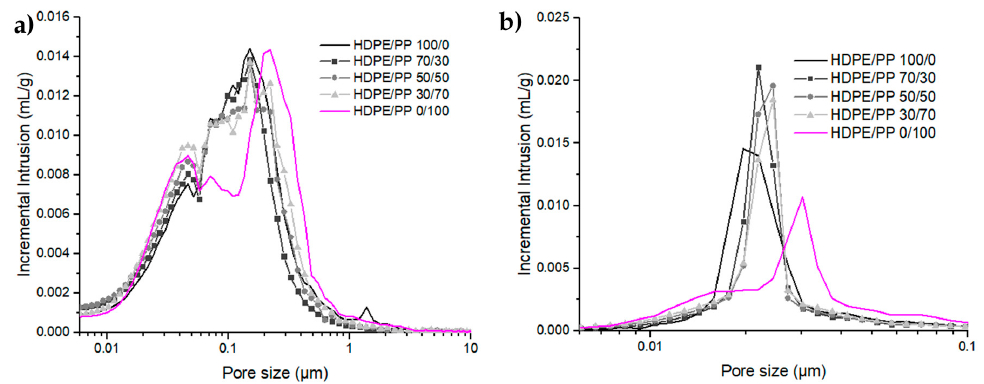
Figure 13. Pore size distribution after waxes solvent extraction for different HDPE/PP ratios: ( a ) 20 vol% and ( b ) 50 vol% of zirconia particles.